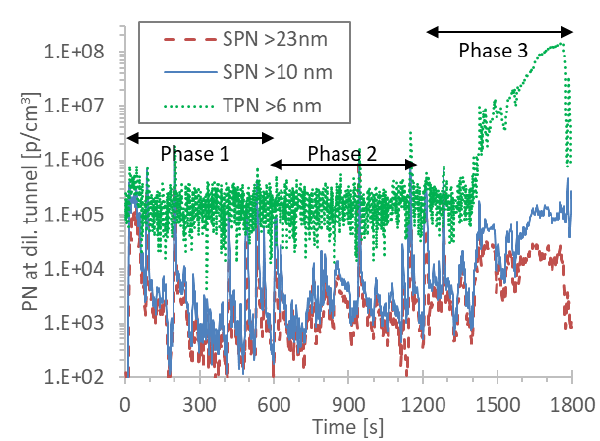
Fig. 5. Particle number (PN) emissions for solid (SPN) or total (TPN) particles as measured from the dilution tunnel. To convert to p/s multiply by 1.0E+05